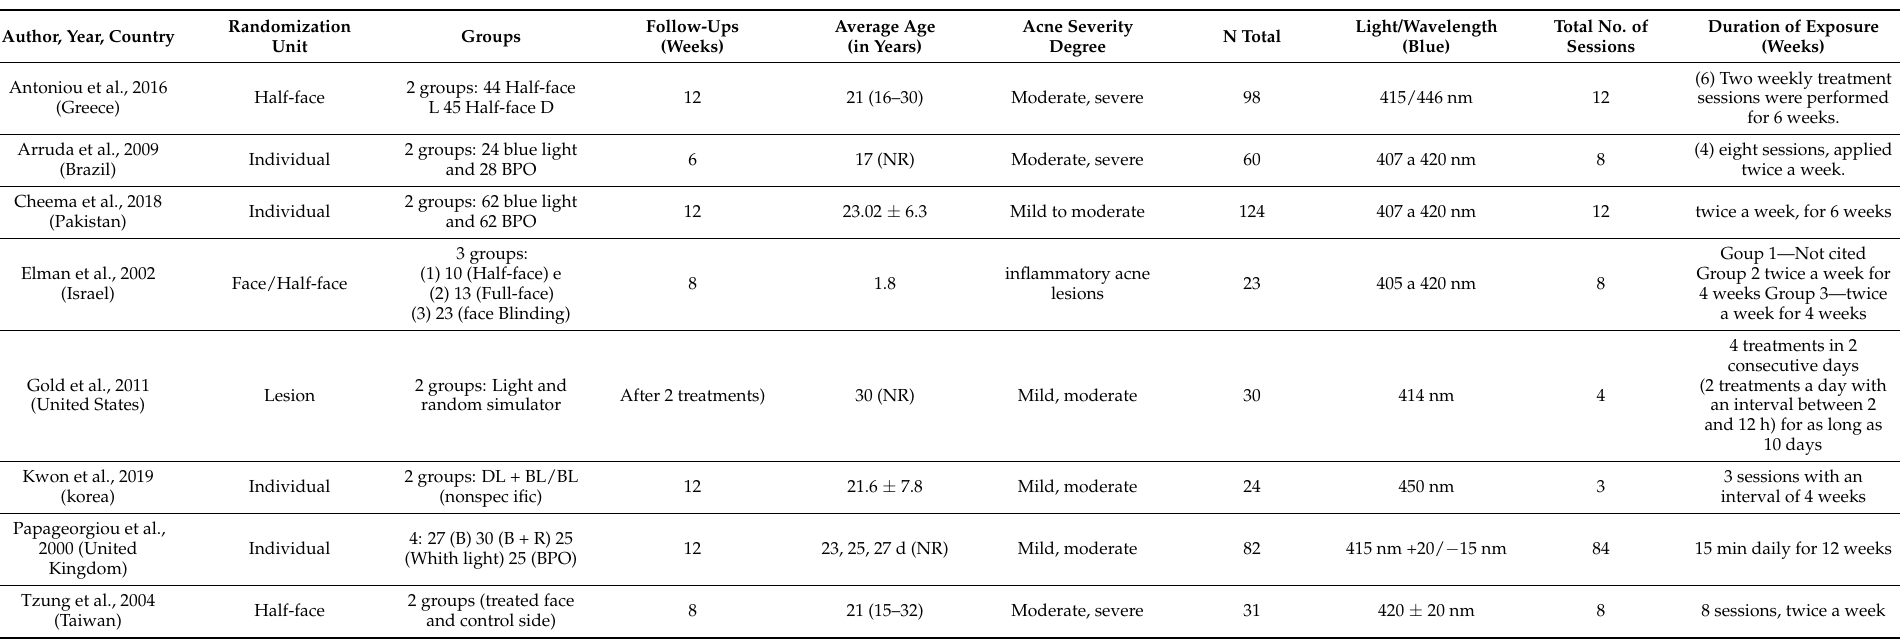
Table 2. Characteristics of the studies included in the systematic